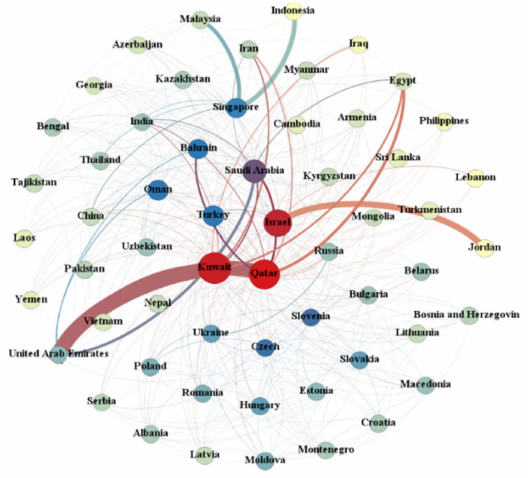
Figure 4. Energy space network of Belt and Road countries in 2003.